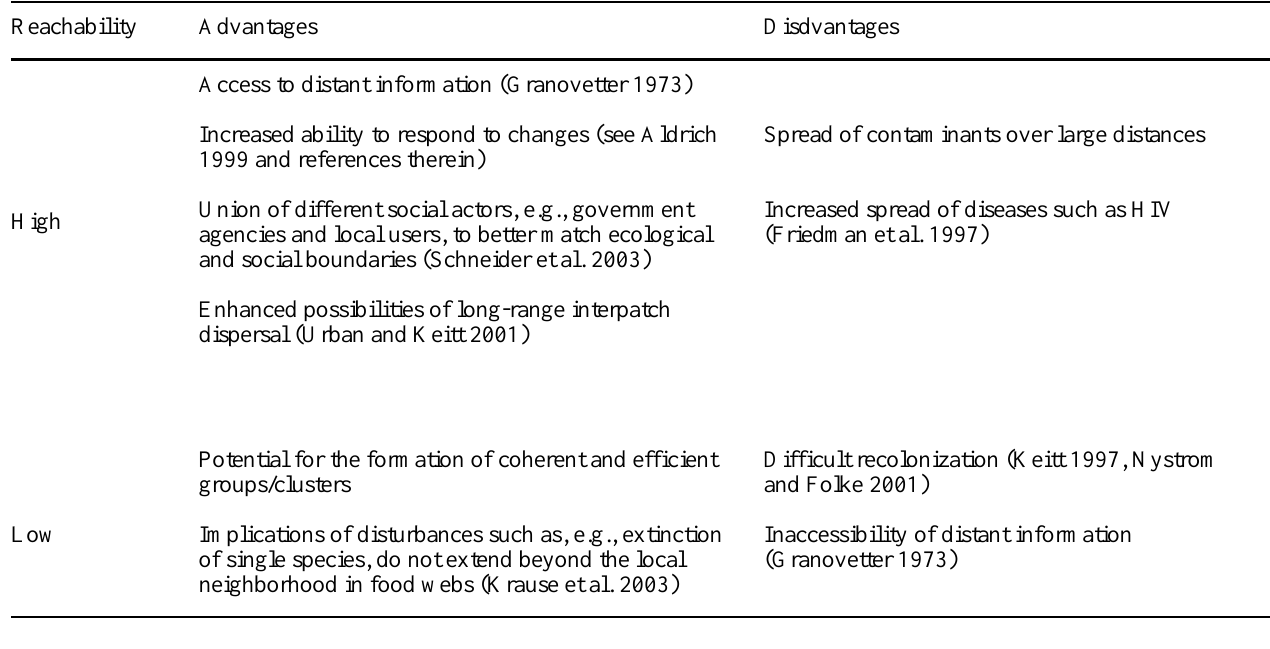
Table 2 . Sensitivity of the performance of a system to differences in reachability.